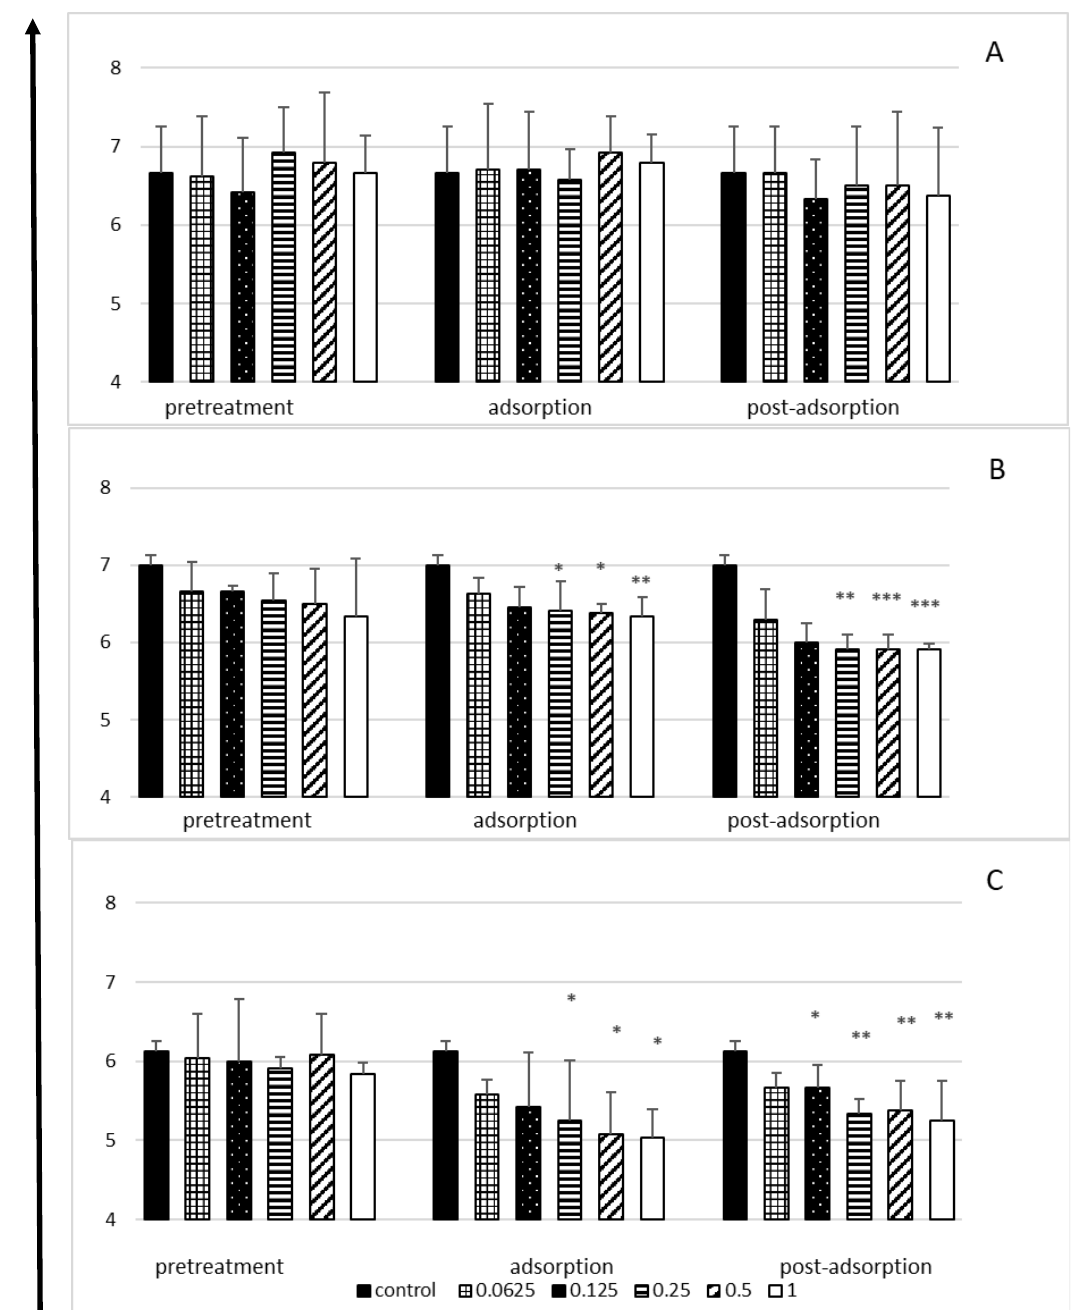
Figure 2. Viral yield reduction by lactoferrin — time-of-addition assay. Cells infected with high (MOI = 10) ( A ), medium (MOI = 1) ( B ) or low (MOI = 0.1) ( C ) infectious doses of enterovirus E. Cells pretreated with lactoferrin for 2 h before infection (pretreatment); lactoferrin present during virus adsorption (adsorption); lactoferrin added just after virus adsorption (post-adsorption). Culture supernatants collected for virus titration (CCID 50 ) after 24 h of incubation. Lactoferrin (LF) concentrations in mg/mL; control: untreated cells. All data expressed as means ± SD (standard deviation) for three independent experiments ( n = 3). Asterisks refer to statistically significant differences between control and lactoferrin-treated cells at: * p < 0.05, ** p < 0.01, *** p < 0.00.